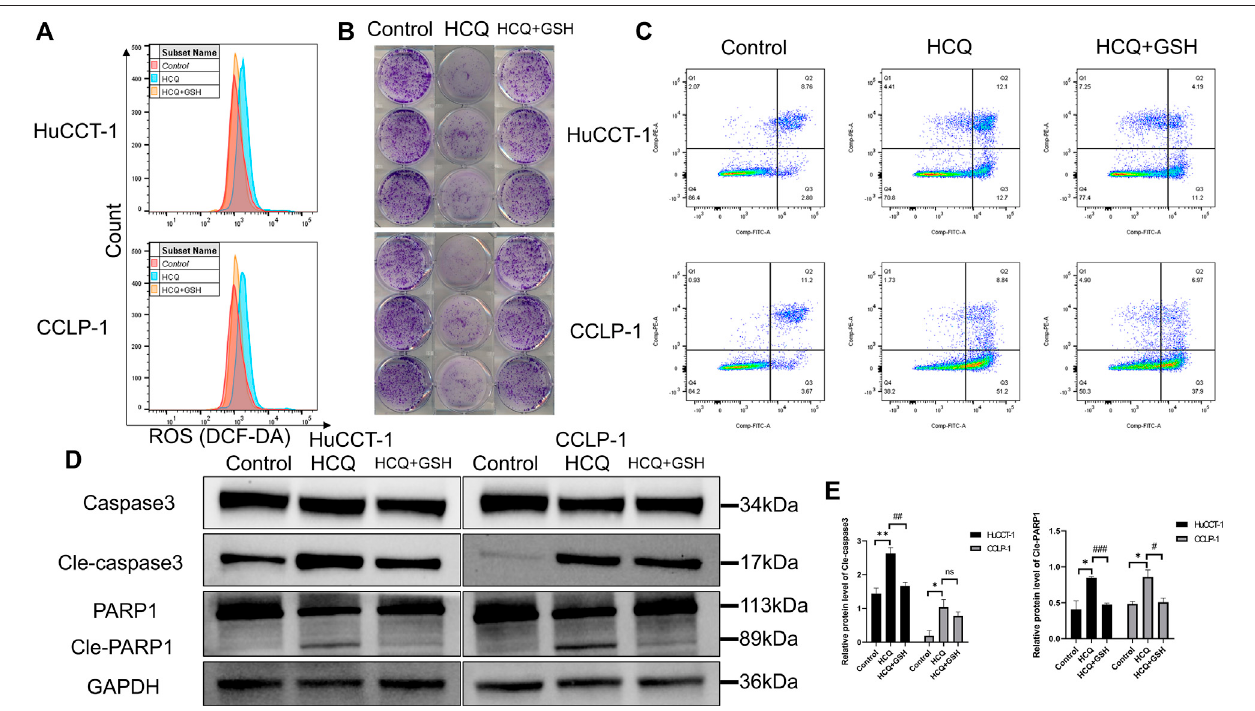
FIGURE 6 | HCQ induces apoptosis in cholangiocarcinoma cells in an ROS-dependent manner. Cells were preincubated with GSH (3 mmol/L) for 2 h and then treatedwithHCQfor24 h. (A) ROSlevelsinHuCCT-1andCCLP-1cellstreatedwithHCQ(IC50)andGSHweredetectedby fl owcytometry. (B) TheeffectofHCQ(IC50) on the colony formation capacity of HuCCT-1 and CCLP-1 cells was reversed by GSH treatment. (C) The effect of HCQ (IC50) on apoptosis of HuCCT-1 and CCLP-1 cellswasreversedbyGSHtreatment. (D) AftertreatmentwithGSH,cleavedcaspase3andcleavedPARP1proteinlevelsweredecreasedinHuCCT-1andCCLP- 1 cells. (E) Quanti fi cation of WB results of cleaved caspase 3 and cleaved PARP1. The results are expressed as mean ± SD. * p < 0.05, ** p < 0.01, signi fi cant difference compared with the control group; # p < 0.05, ## p < 0.01, ### p < 0.001, signi fi cant difference compared with the HCQ